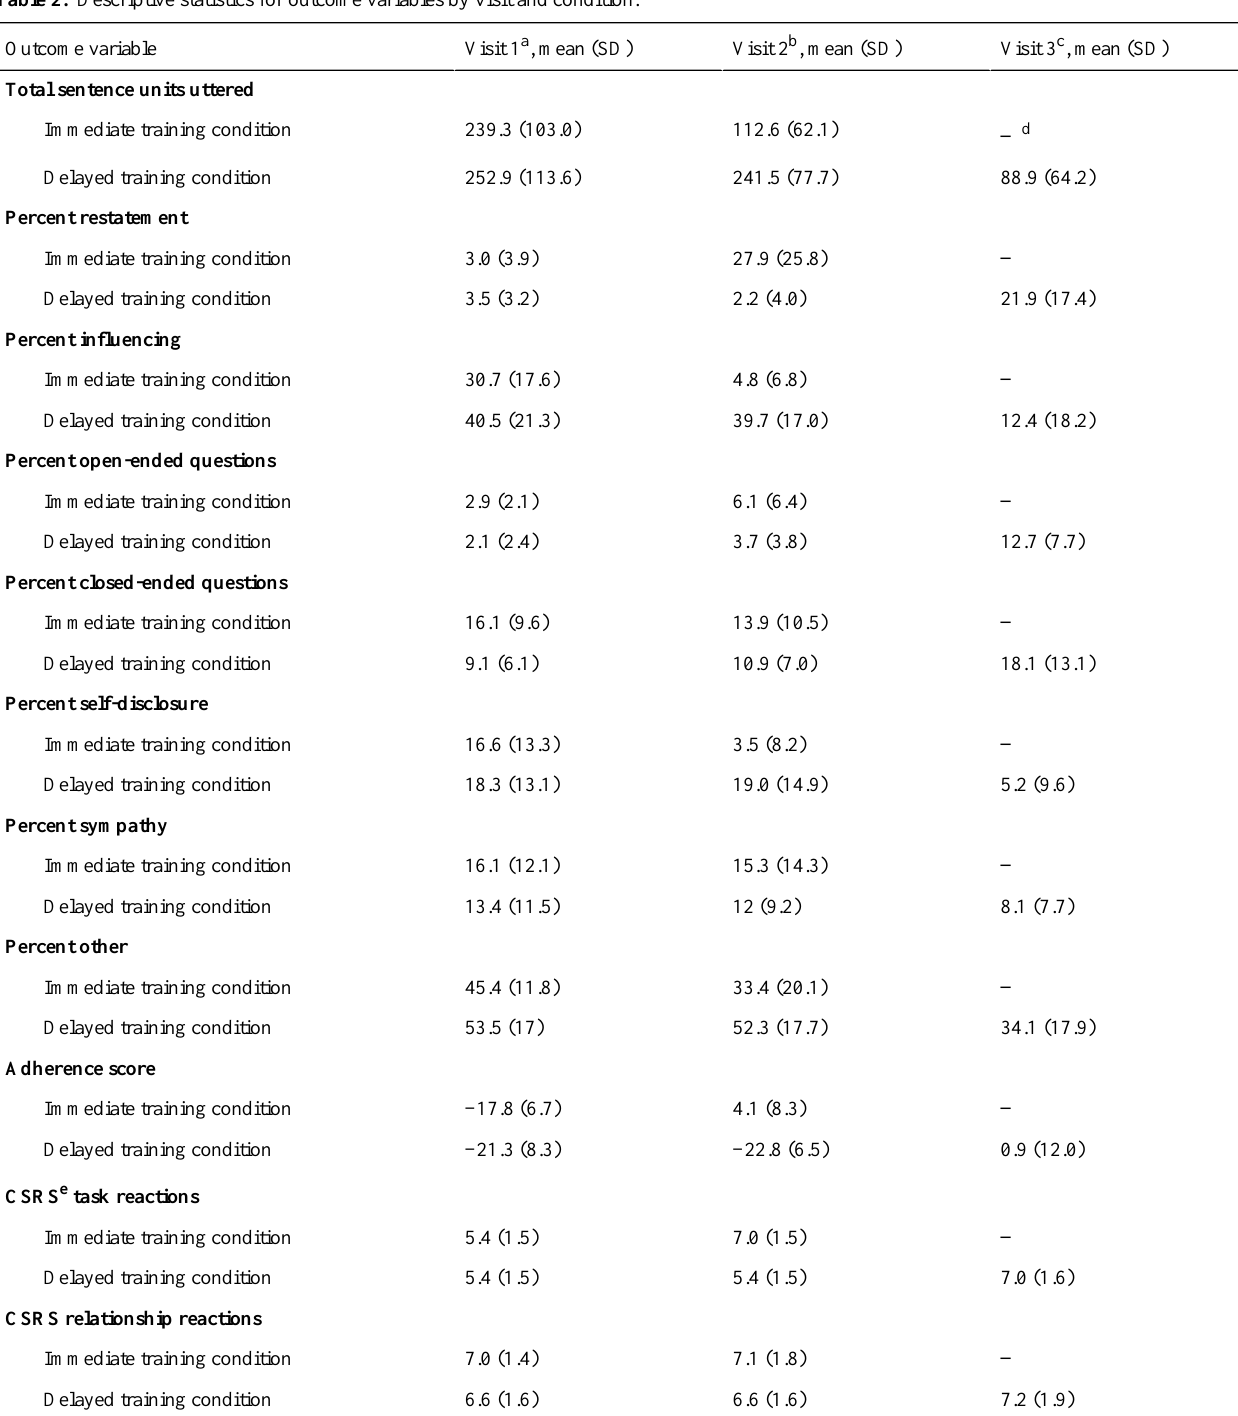
Table 2. Descriptive statistics for outcome variables by visit and